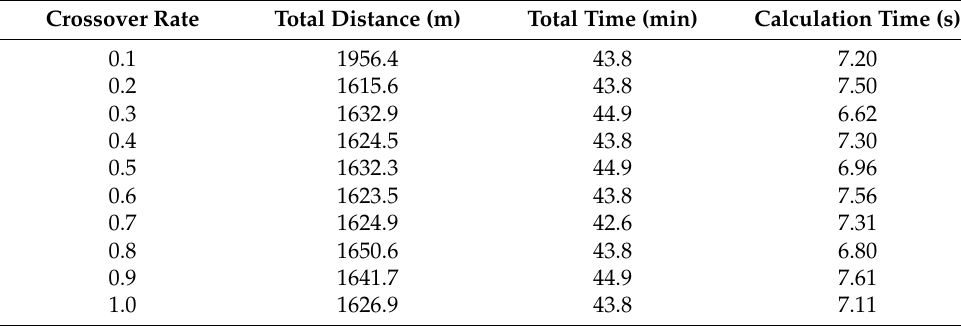
Table 1. Influence of crossover rate on